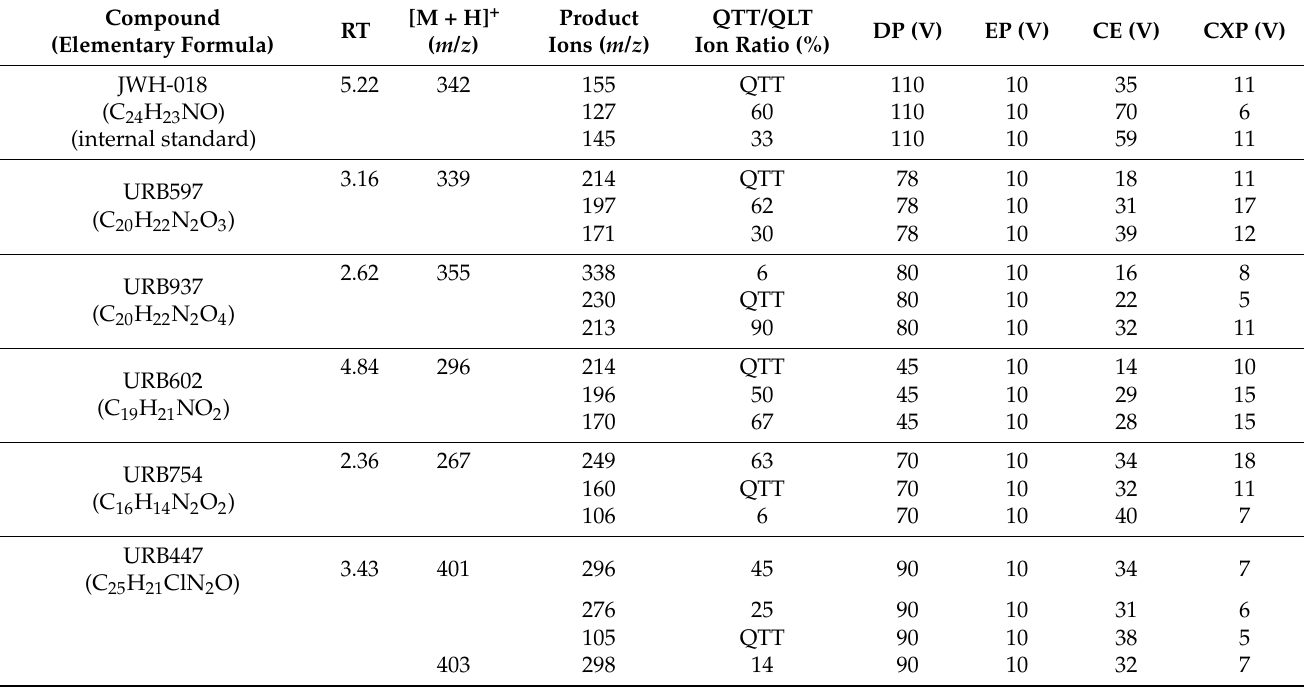
Table 1. Compound-dependent parameters for optimal monitoring of multiple